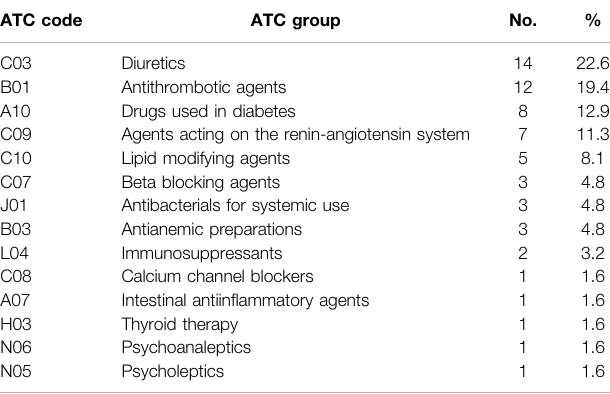
TABLE 7 | ATC classi fi cation of medication classes involved in DRAs related to treatment effectiveness (N = 62). ATC code